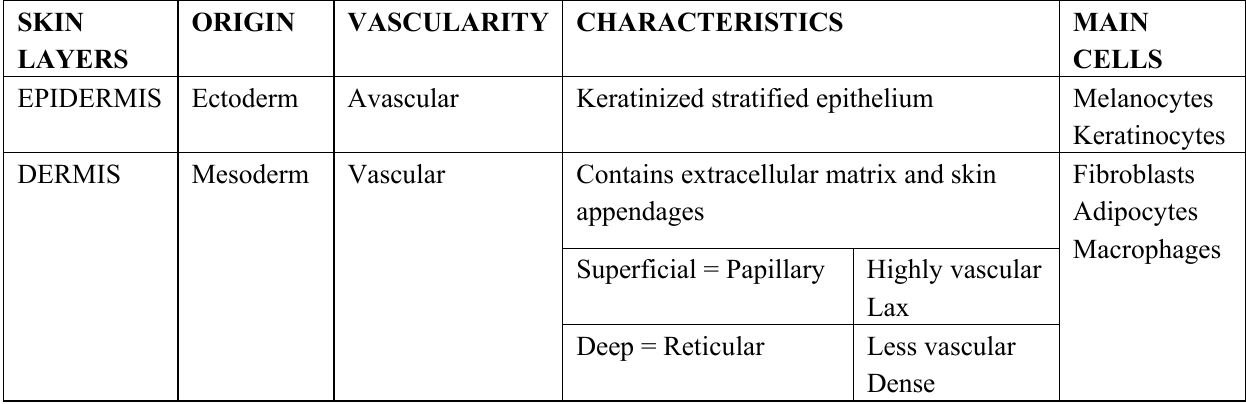
Table 1. Main differences between epidermis and dermis skin